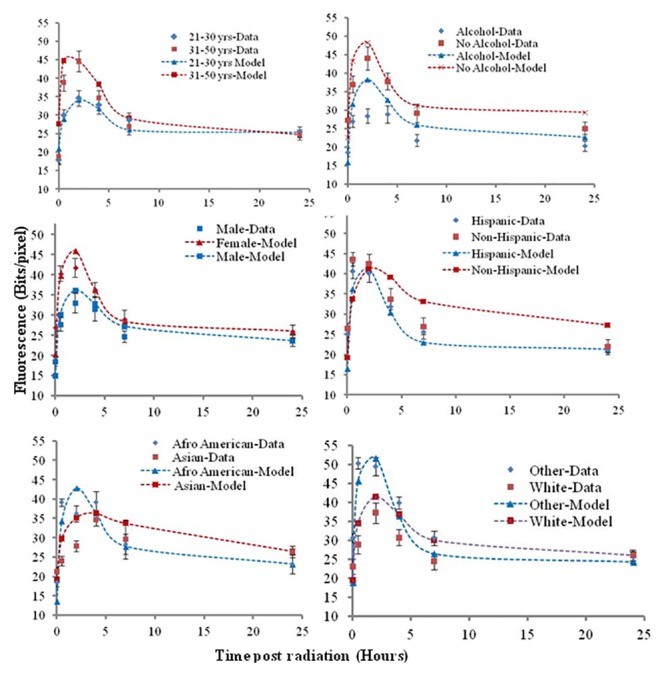
γ-H2AX yields repair kinetics based on demographic groups.(a) Experimental data and model fit (from Equation 1) of γ-H2AX foci repair kinetics at 0.5 h, 2 h, 4 h, 7 h and 24 h post ex vivo gamma irradiation based on (A) age (B) alcohol use (C) gender (D) ethnicity (E) and (F) racial groups. The data obtained is plotted as points with error bars. The predictions from the model are depicted with correspondingly colored dotted lines. Error bars are ±SEM.